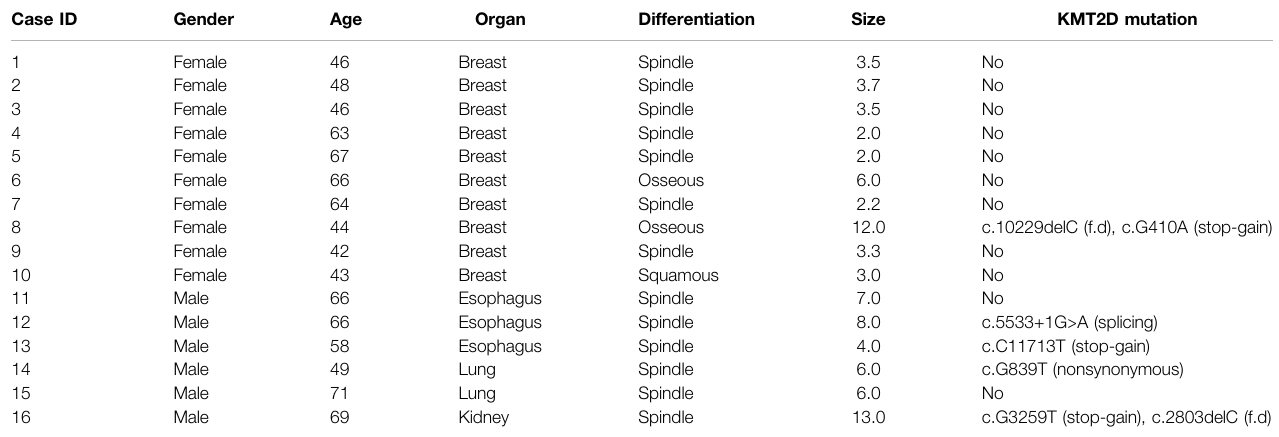
TABLE 1 | Characteristics of